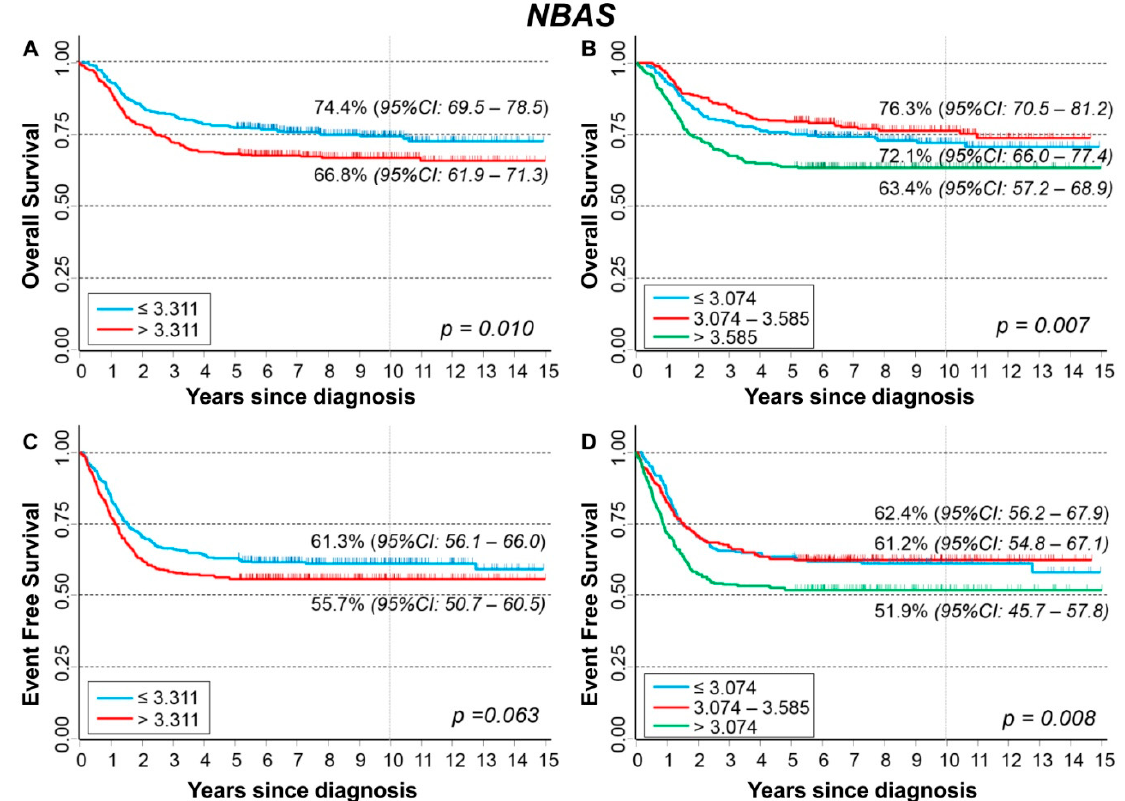
Figure 22. Patient Survival in relation to NBAS expression level. Overall Survival of 786 NB patients with ( A ) cut-off based on the median expression value or ( B ) on tertile expression values. Event Free Survival of 769 NB patients with ( C ) cut-off based on the median expression value or ( D ) on tertile expression values. Ten-year survival estimates are displayed.